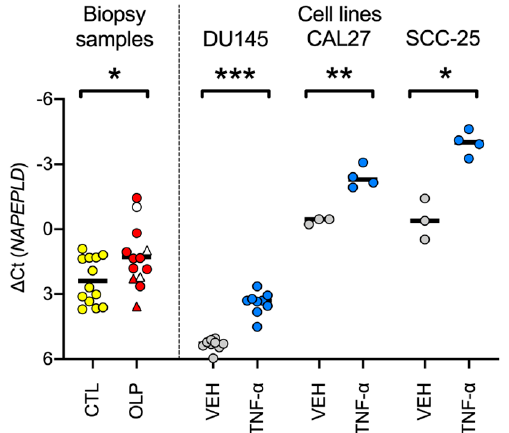
Figure 2. mRNA levels of PTGS2 with NAPEPLD as reference gene in the biopsy samples and in three human cell lines treated with either vehicle or TNF- α . Control (CTL) biopsy samples are shown as yellow circles. For OLP, the triangles are cases without accompanying genital/skin pathology, and the circles are those with accompanying genital/skin pathology. The unfilled symbols are cases without atrophic pathology; the red symbols are cases with atrophic pathology. The data for the human DU145 prostate carcinoma cells are calculated from the raw data from Figure 1C of [29] using a two-hour exposure time to either vehicle (VEH, grey circles) or TNF- α (20 ng / mL, blue circles). The data for the two human squamous carcinoma cell lines (CAL27 and SCC-25) are calculated from the raw data shown in Supplemental Figures S1 and S2 and used a 24 h incubation time with either vehicle or TNF- α (10 ng / mL). The bars in the scatter plots represent the mean values. * p < 0.01, ** p < 0.01, and *** p < 0.001, two-tailed t -tests not assuming equal variance. At a 5% false discovery rate, the critical value of p was